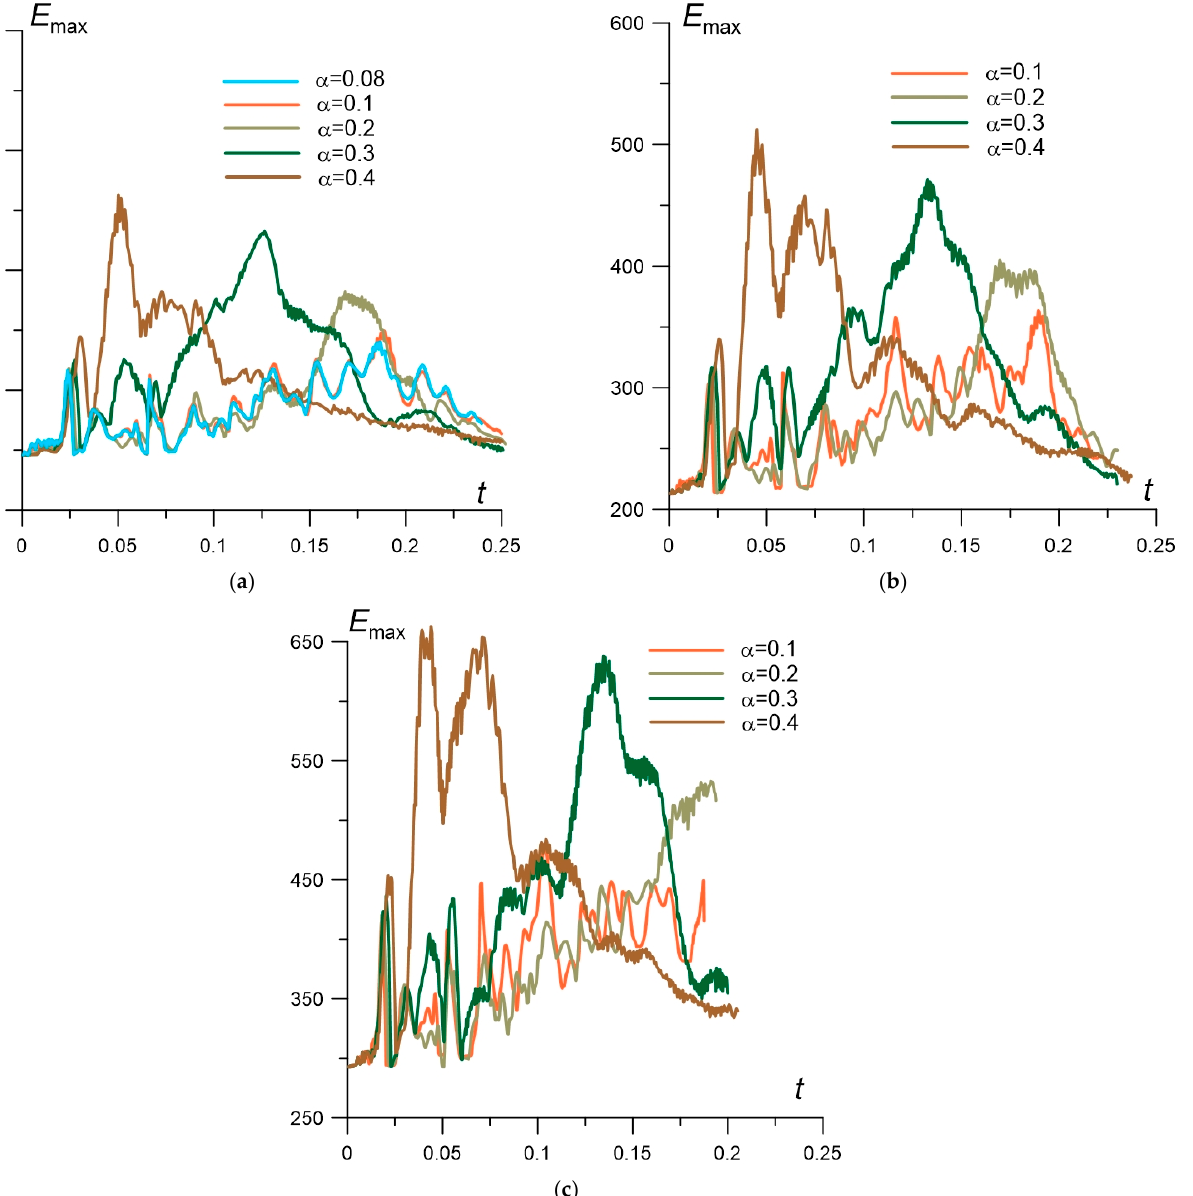
Figure 12. Dynamics of E max for different α : ( a ) M = 6; ( b ) M = 7; ( c ) M = 8.